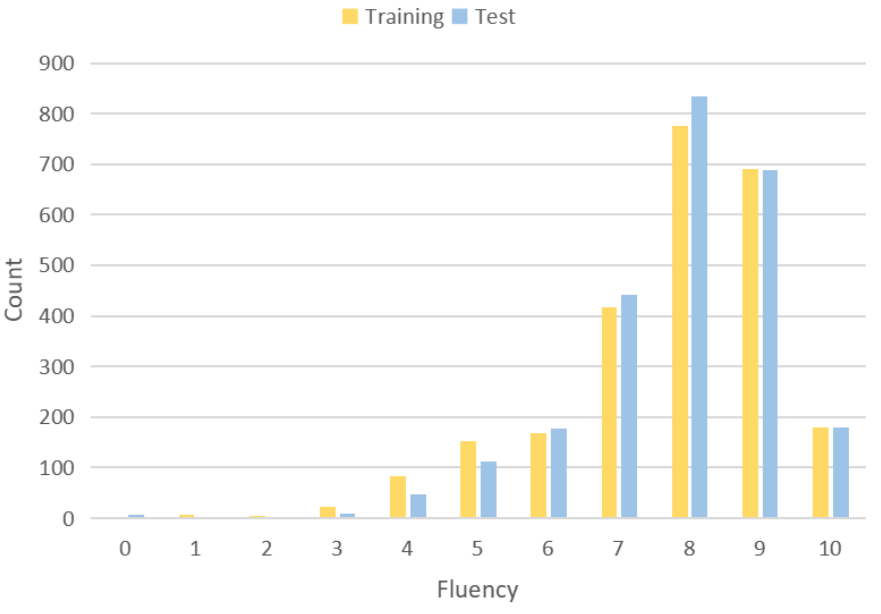
Figure 6. The distribution of fluency scores on the training and test sets of Speechocean762.